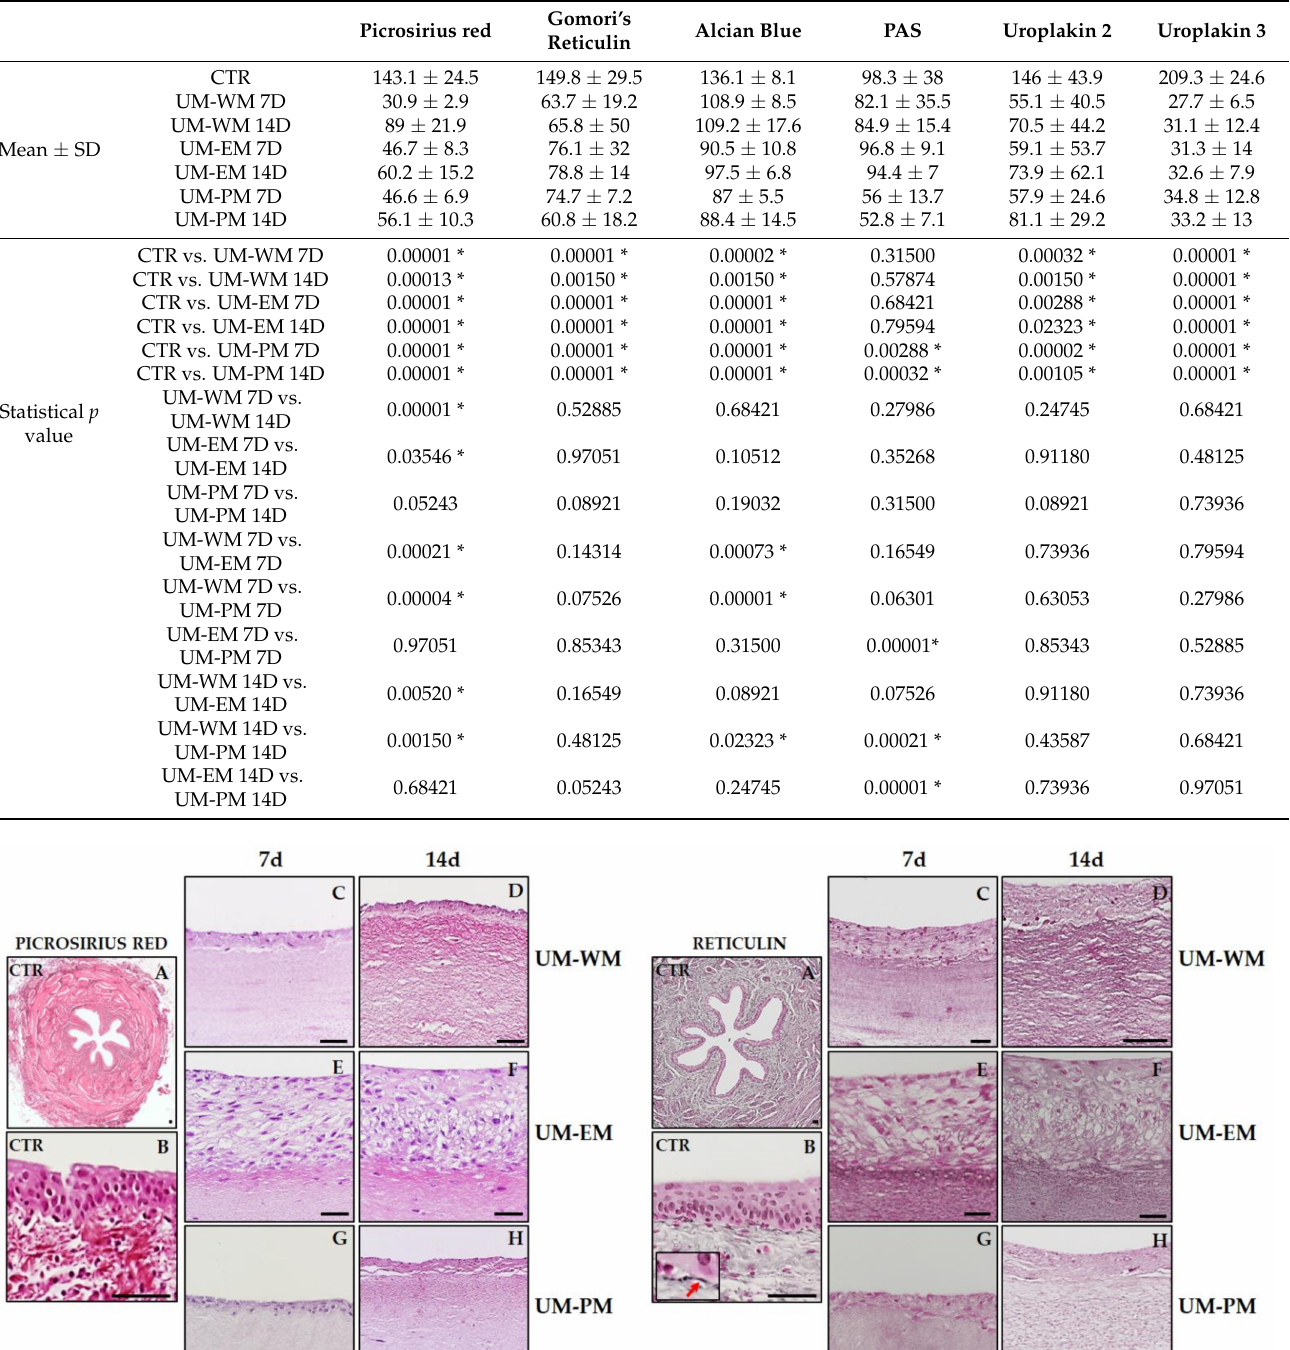
Table 1. Quantitative analysis of fibrillar and nonfibrillar ECM components in control native UM (CTR) and in the stromal substitute of heterotypical substitutes of the human UM cultured in WM, EM, and PM media for 7 and 14 days as determined by picrosirius red, Gomori’s reticulin, alcian blue, PAS histochemistry, and epithelial uroplakins as determined by immunohistochemistry. Results were quantified and compared among groups using the statistical test of Mann–Whitney. Statistically significant values are labeled with asterisks (*).